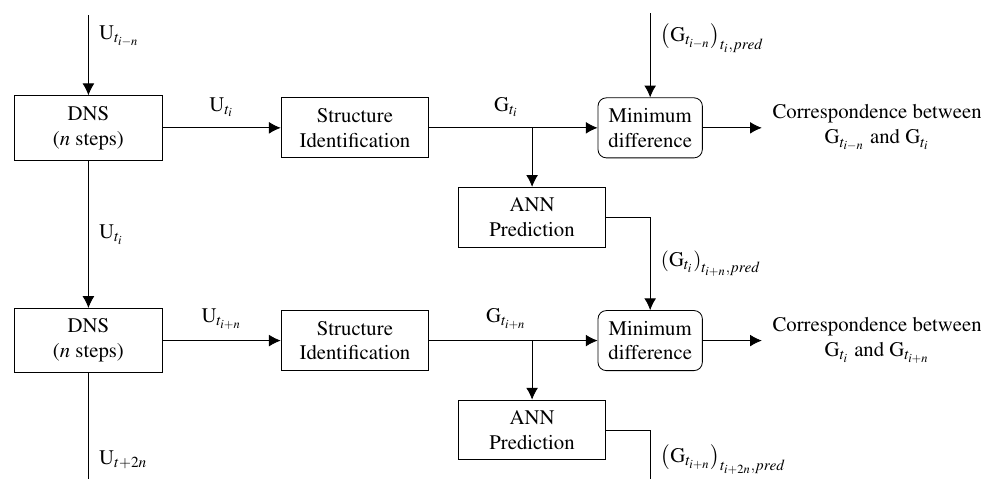
Figure 6. Flowchart of the proposed implementation of the use of Artificial Neural Networks (ANN) in the process of tracking Qs in a DNS simulation. U t the set of features of the Qs of time step t i . The ANN takes the features of the Qs and predicts the their values in the next timestep, so that they can be compared to the features of the Qs in the next time step.